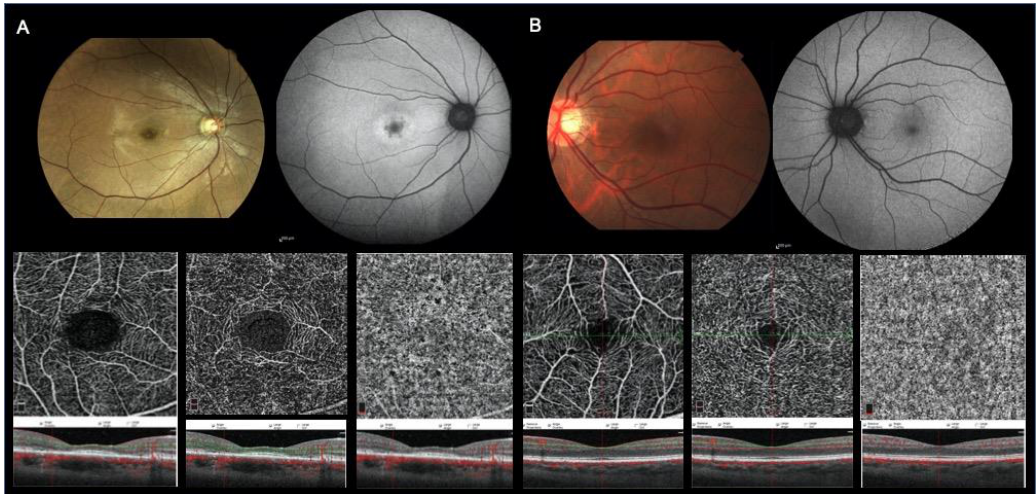
Figure 2. Multimodal imaging of a cone dystrophy eye of 42-year-old patient and a normal control eye of a 48-year-old patient ( A and B images, respectively). ( A ) Colour fundus photograph (CFP) showing central retinal pigment epithelium (RPE) changes (first row, left); fundus autofluorescence (FAF) revealing central areas of increased autofluorescence (first row, right); optical coherence tomography angiography (OCTA) of the superficial capillary plexus (SCP) (second row, left), deep capillary plexus (DCP) (second row, middle) and choriocapillaris (CC) (second row, right) showing some interruptions of the perifoveal anastomotic arcade in the superficial plexus and no apparent modifications of the deep plexus and choriocapillaris; corresponding structural SD – OCT images from vertical and horizontal scans centred on the fovea (third row left, middle and right with overlying segmentation bands at the level of the SCP, DCP and CC, respectively) showing central subfoveal external limiting membrane and inner segment ellipsoid band defects, photoreceptor outer segment defects and slightly thin subfoveal RPE/Bruchs complex. ( B ) CFP (first row left), FAF (first row right), OCTA of the SCP, DCP and CC (second row left, middle and right respectively) and SD – OCT (third row left, middle and right with overlying segmentation bands at the level of the SCP, DCP and CC, respectively) of a normal eye. Table 3. Morphological parameters of cases and controls expressed as median and interquartile range. Variable Cases